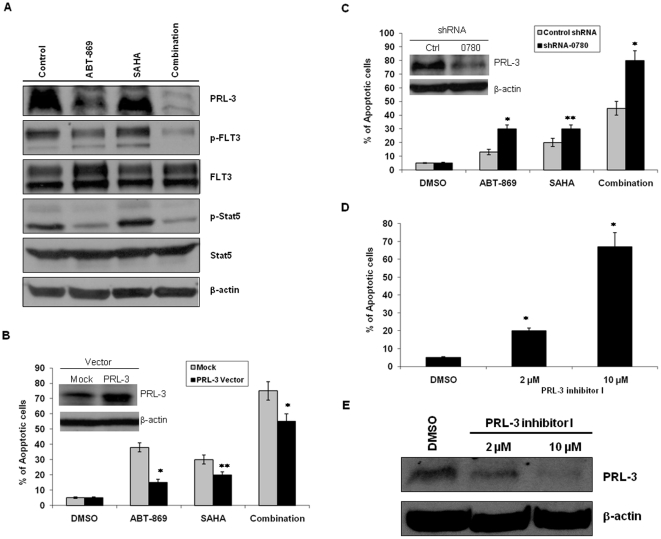
Impact of modulation of PRL-3 expression on drug sensitivity.(A) MOLM-14 cells were treated with DMSO, ABT-869 6 nM, SAHA 4 µM or combination therapy for 48 hours, and then followed by lyses and Western blot analysis of PRL-3, p-Stat5, Stat5. Immunoprecipitation (IP) was performed using anti-p-Tyrosine antibody, followed by Western blot with anti-FLT3 antibody. The same blot was then stripped and reprobed with anti-FLT3 antibody. The upper band is160 kDa glycosylated mature FLT3 and the lower band is 130 kDa nonglycosylated FLT3. (B) MOLM-14 cells were transfected with vector control (Mock) or pLVX-puro-PRL3 vector. Cells were treated with either ABT-869 6 nM, SAHA 4 µM or combination therapy for 48 hours. (C) MOLM-14 cells were transfected with control and PRL-3 shRNA-0780 respectively for 48 hours, and then treated with ABT-869 3 nM, SAHA 2 µM or combination therapy for 72 hours. Apoptosis assay was used to determine the cell viability in different treatments. (D) Flow cytomertric analysis of apoptosis in MOLM-14 cells were treated with either DMSO control or PRL-3 inhibitor I at concentration 2 and 10 µM for 48 h. (E) Effect of PRL-3 inhibitor I on PRL-3 protein expression. Apoptosis data shown represents the means of three independent experiments ± SD (*p<0.01, **p<0.05).